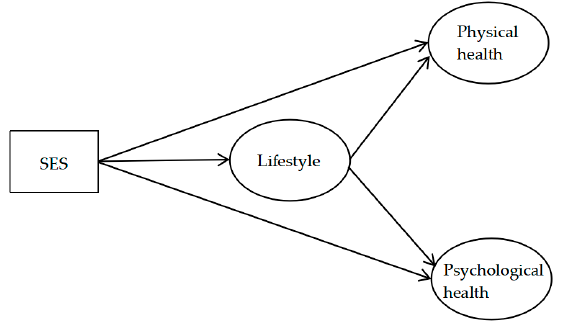
Figure 1. Conceptual framework.